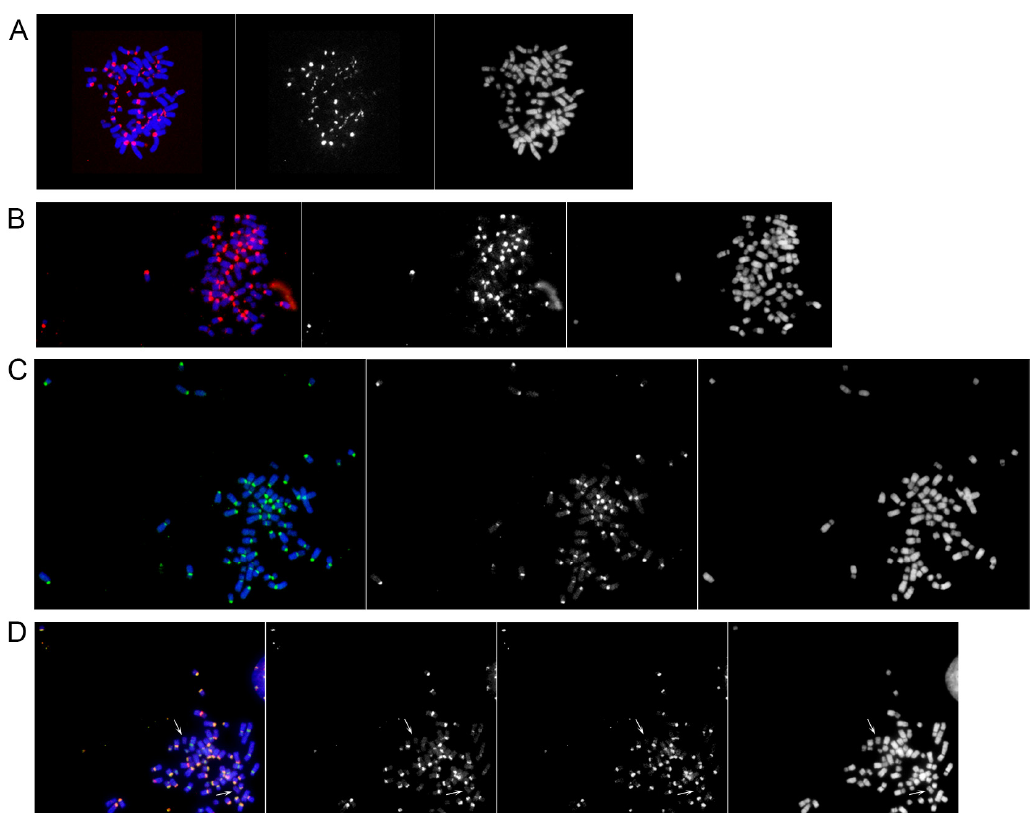
Figure 3. Hybridization of satellite DNA probes with metaphase chromosomes of E. przewalskii . Single-color FISH experiments with three satellite DNA probes: ( A ) 37cen (red signals), ( B ) 2PI (red signals), and ( C ) total genomic DNA (green signals). In panel ( D ), two-color FISH with 2PI probe (red signals) and total genomic DNA (green signals). The white arrows indicate chromosome 10, which is the only chromosome pair lacking any hybridization signal.